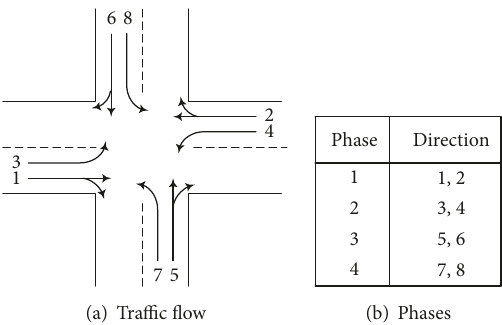
Figure 1: Traffic flow and phases of signalized